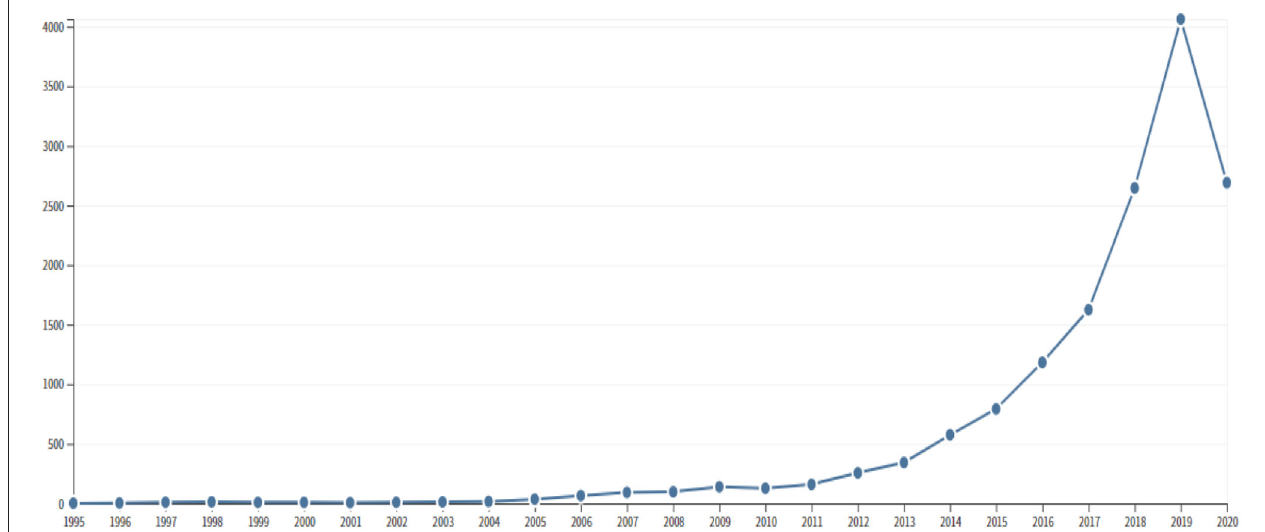
FIGURE 1 | Citation pattern for 1,630 publications on telemedicine in Arab countries through July 7, 2020.